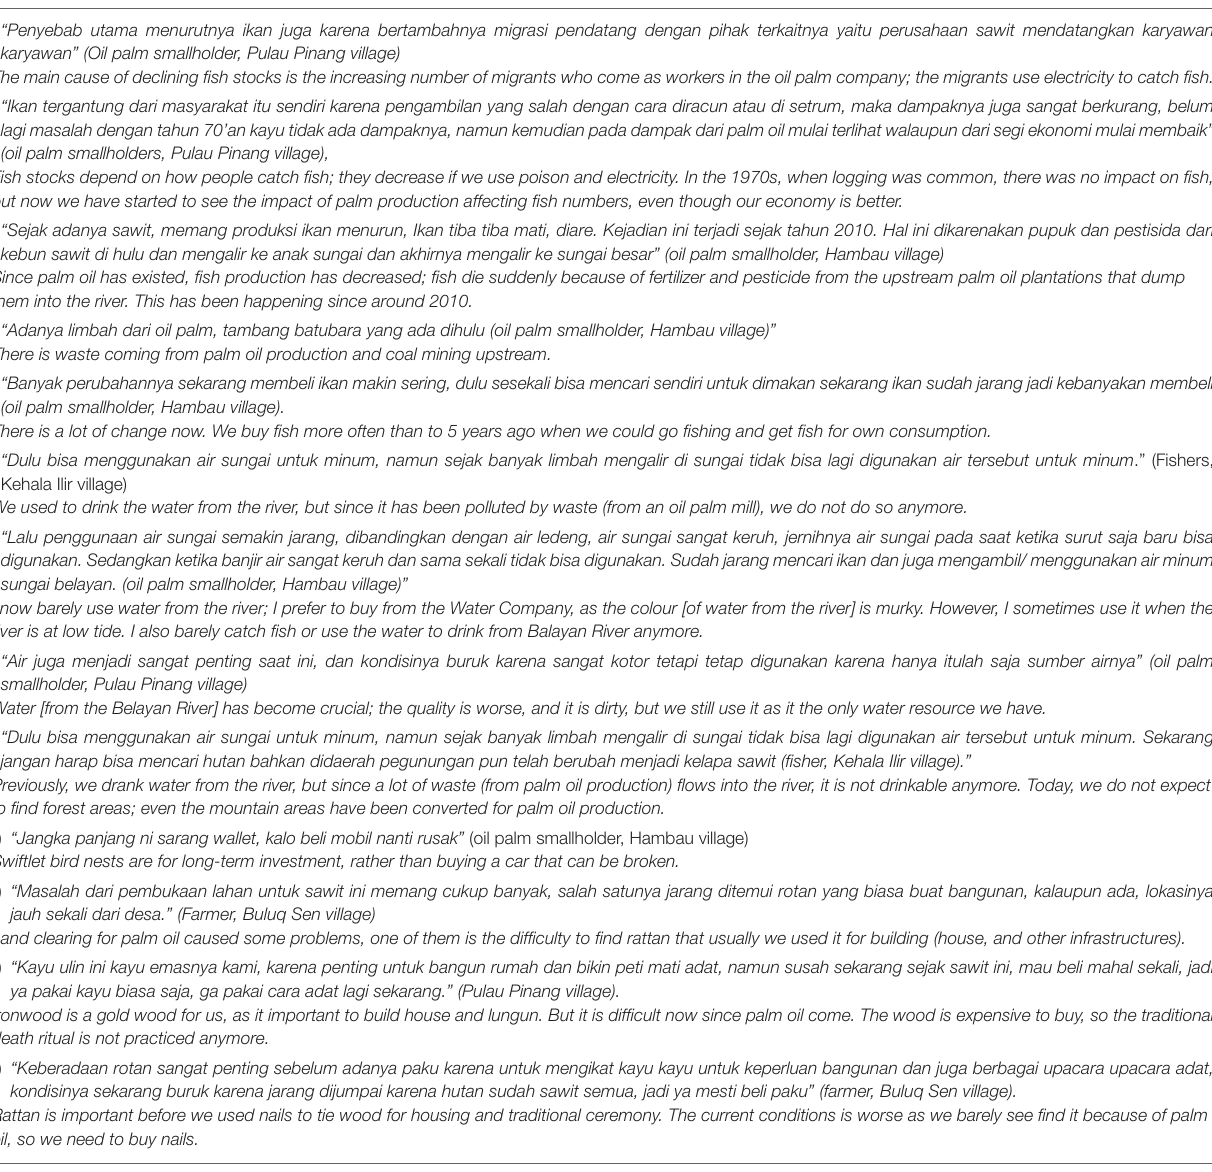
TABLE 4 | Statements of local communities on the driver of ES